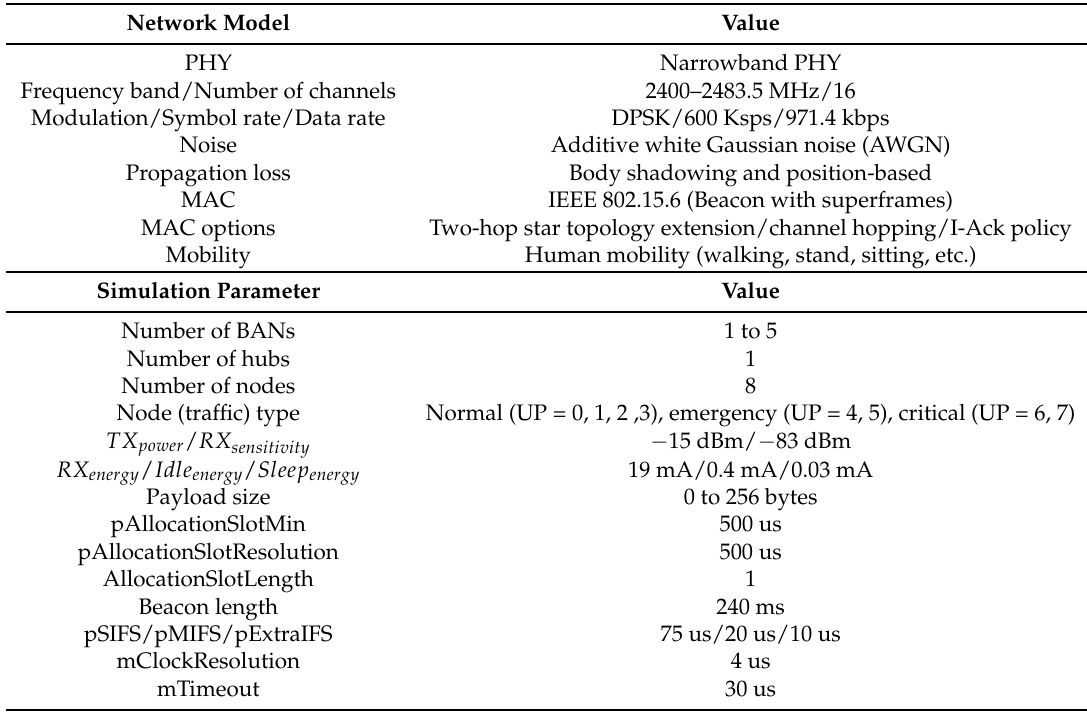
Table 5. Simulation